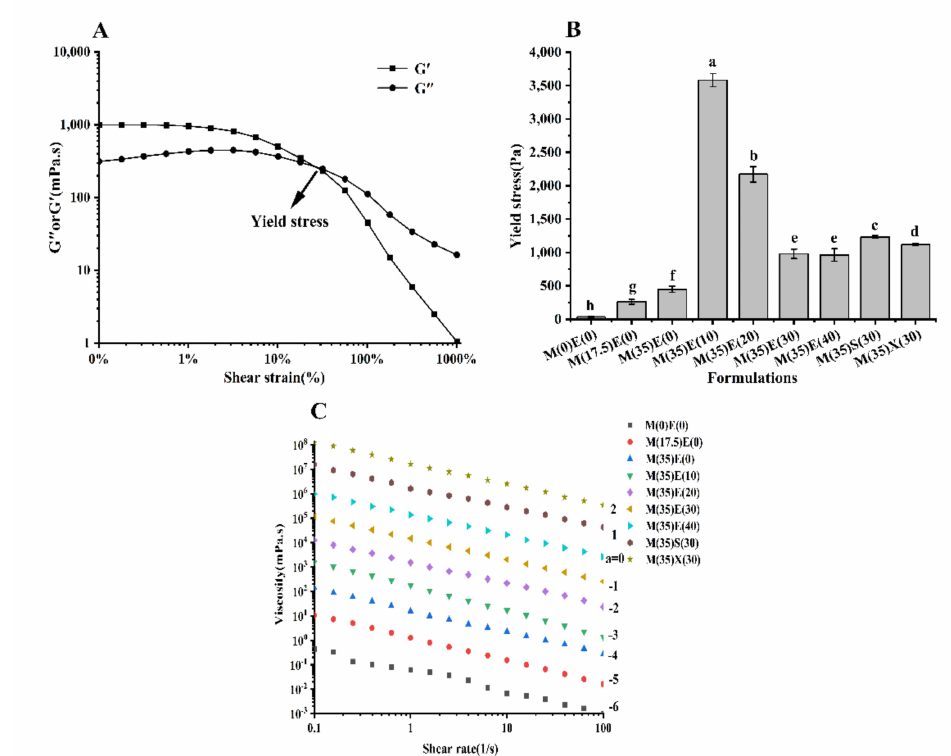
Figure 3. ( A ) Illustrative example of yield stress for the composition M(17.5)E(0) at 75 ◦ C. The yield stress of inks has been determined as the cross-over point where G (cid:48) equals to G (cid:48)(cid:48) . ( B ) Yield stress of inks with different polyol formulations at 75 ◦ C. ( C ) Viscosity for different inks at temperature of 75 ◦ C over shear rate of 0.01–100 1/s. Different lowercase letters denote significant differences ( p <